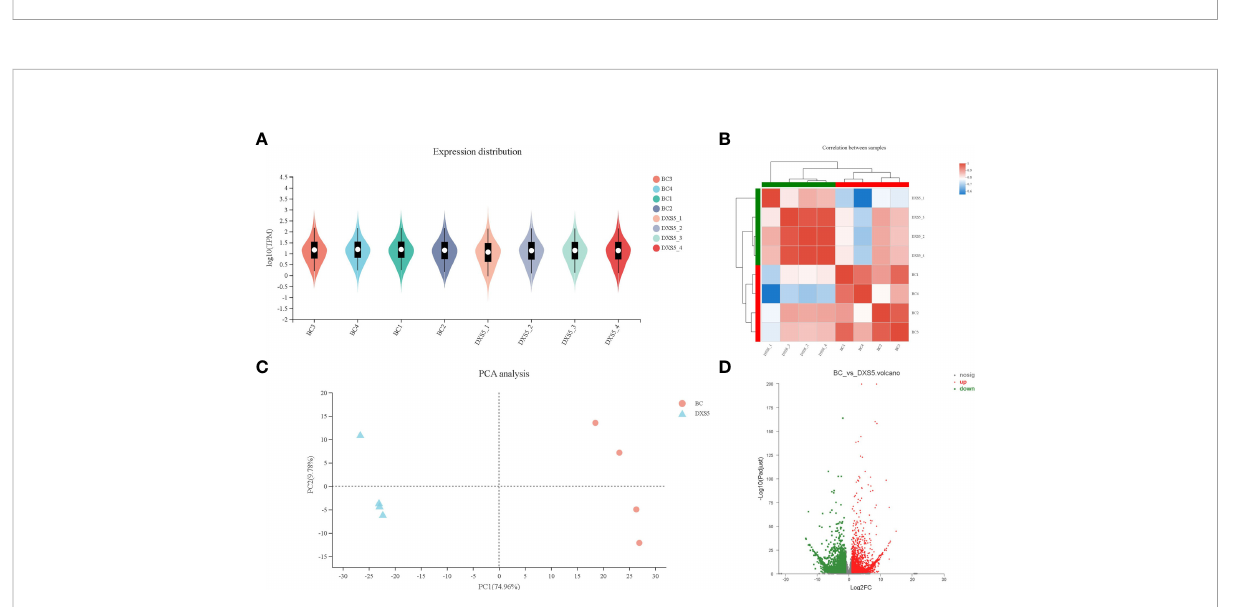
FIGURE 5 Analysis of differentially expressed genes (DEGs). (A) differentially expressed genes expression distribution. (B) differentially expressed genes correlation analysis between samples. (C) principal component analysis (PCA) of each group. (D) Volcano plot of differentially expressed genes between the 2 libraries, red and green dots represent the signi fi cantly upregulated and downregulated